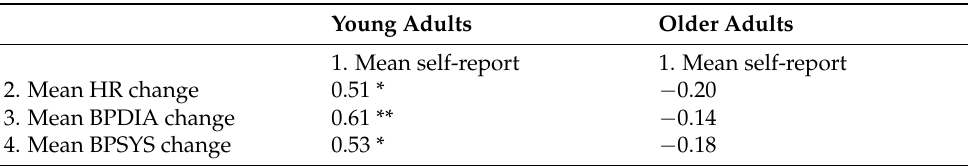
Table 3. Pearson correlations between the three physiological indices: mean HR change, mean BPDIA change, mean BPSYS change, and self-reported physiological arousal for the two age